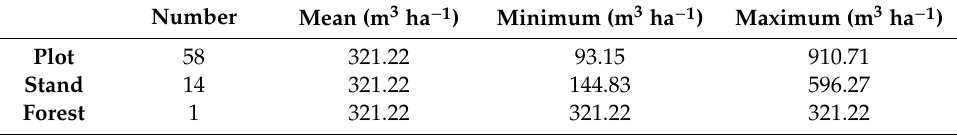
Figure 1. Overview of the study area location and sampling design. Table 1. Summary statistics for growing stock volume at the di ff erent spatial scales (plot, stand, and forest